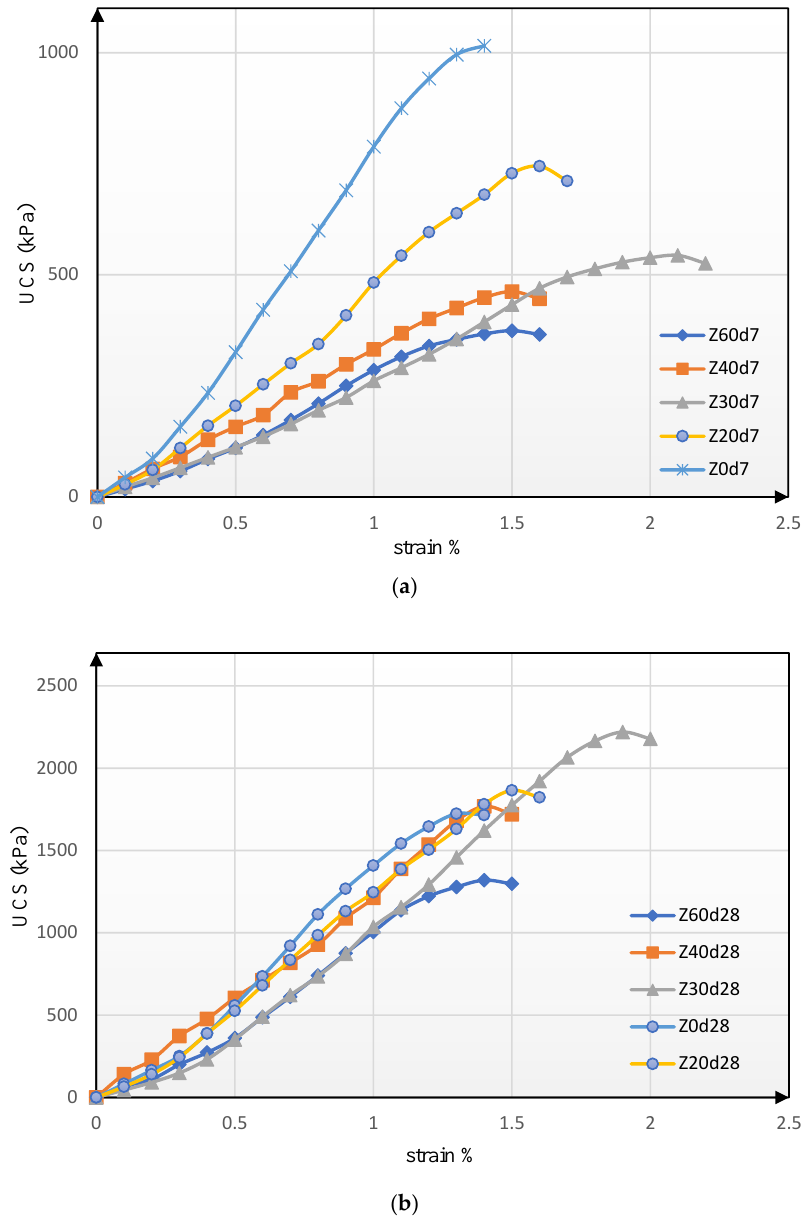
Figure 5. Stress-strain diagrams for different samples during a treatment period of ( a ) 7 days and ( b ) 28 days.